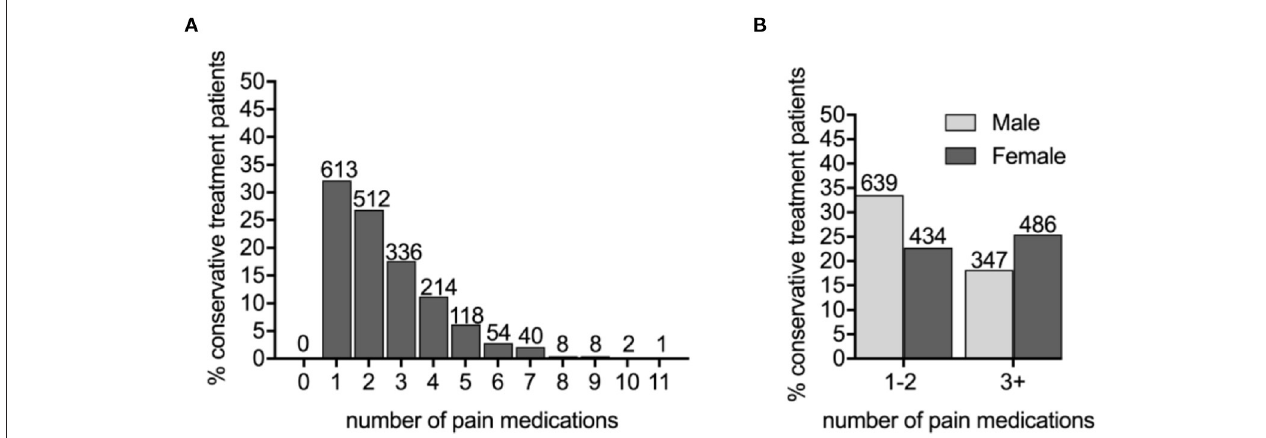
FIGURE 3 | The PDN patients prescribed three or more pain medications are more likely to be female. (A) The number of different pain medications taken by conservatively treated PDN patients. (B) Male and female conservatively treated patients were prescribed one–two or three or more pain medications (X 2 = 28.2479, p < 0.0001).